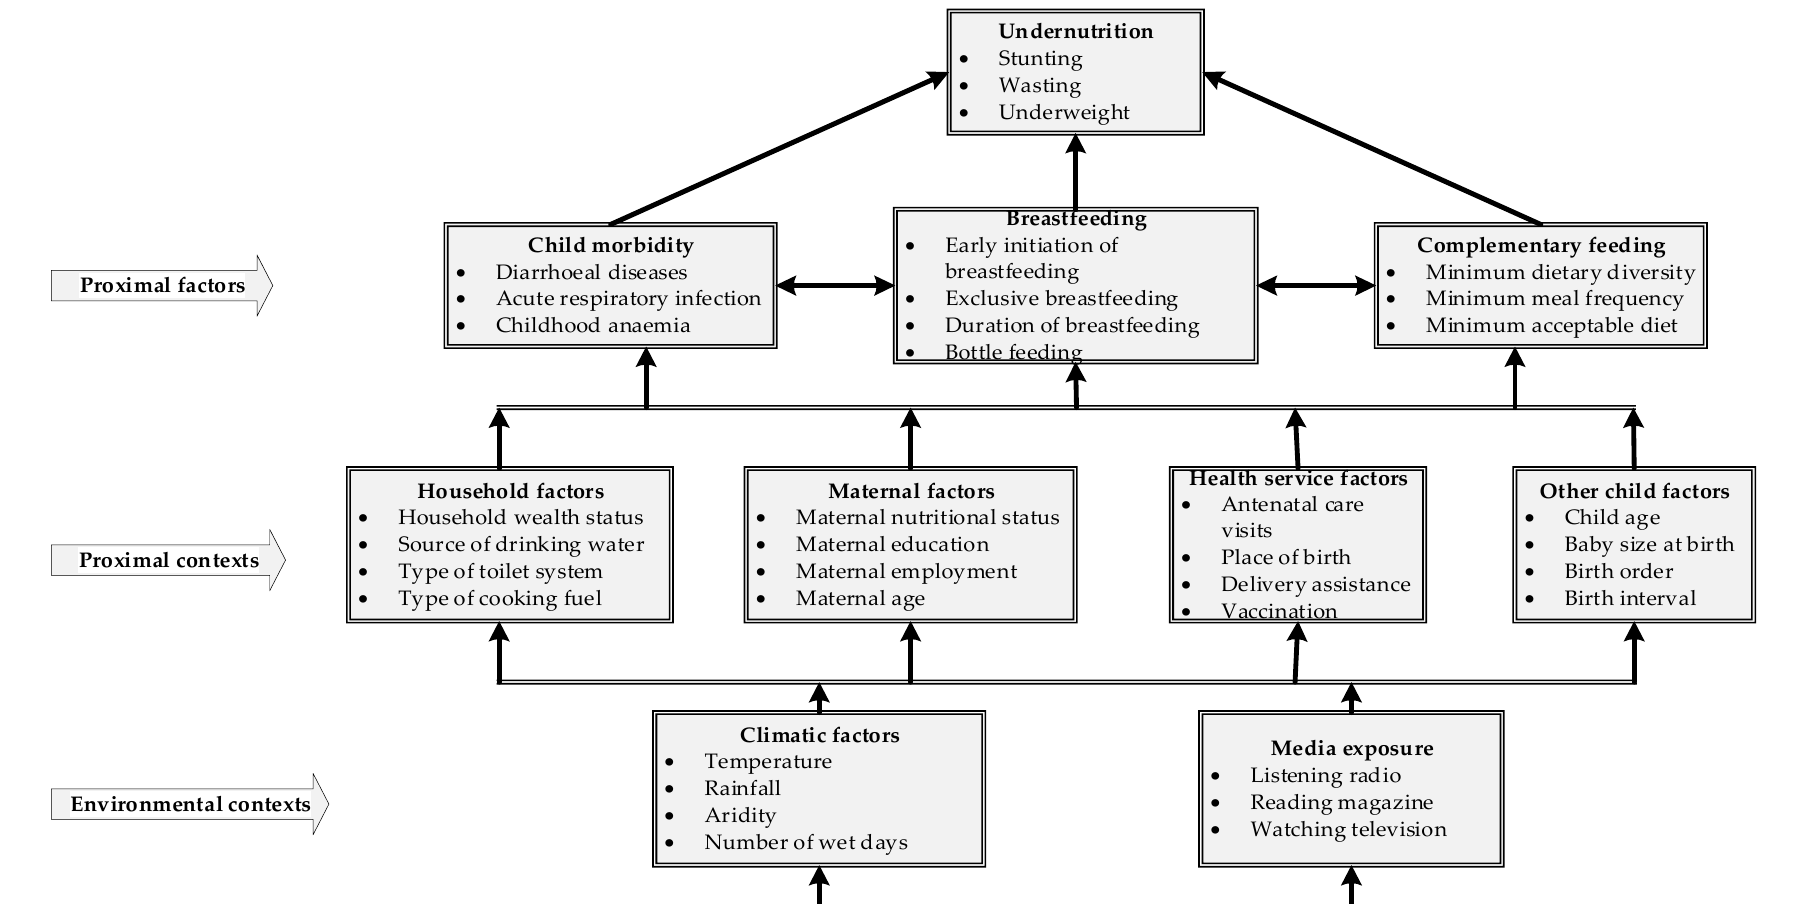
Figure 1. Conceptual framework for proximal and contextual factors associated with stunting among children under five years of age (adapted from UNICEF 2013 [7] and WHO 2017 [47] ).